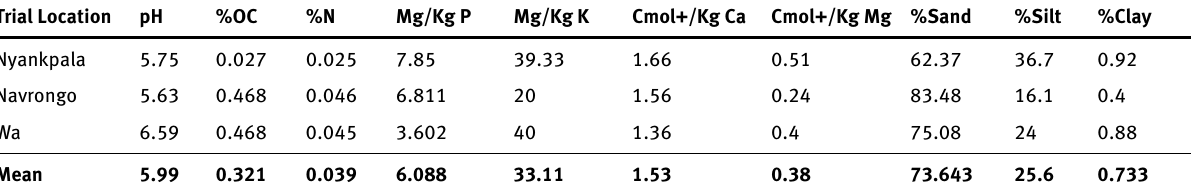
Table 1: Soil analysis for the three trial locations Trial